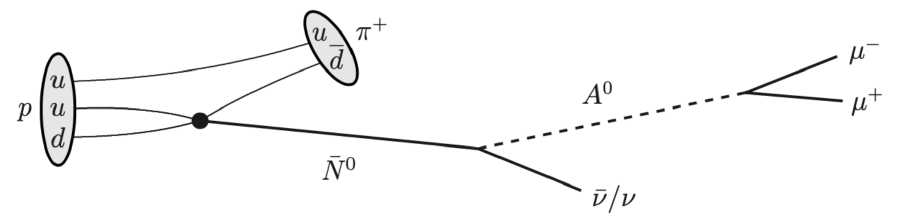
Figure 5 . Exotic proton decay p → ¯ N 0 π + followed by the decay of the antiparticle ¯ N 0 of the “right-handed neutrino” via a light pseudoscalar A 0